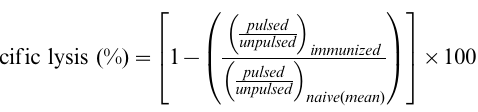
Figure 4. Fragmentation of Gag p24 broadens the T-cell repertoire. HLA-A2/DR-transgenic mice were immunized three times with either the full set of overlapping peptides (OLGa, 2 m g/peptide) with or without CAF05 or protein (5 m g) in CAF05. Naı¨ve mice where used as the negative control. 10 days after the last immunization, splenocytes from individual mice were restimulated with the indicated peptide pool (see Table 1) and the frequency of IFN- c -producing cells was determined by ELISPOT. Shown are values after background subtraction. Black symbols indicate a significant response for that individual mice as determined by the DFR(x2) method. If a significant response was detected in either the protein/CAF05 or peptides/CAF05 group, statistically significant differences in SFU-levels between these two groups only were determined based on a one-tailed t test and P -values are indicated. NS, not significant.